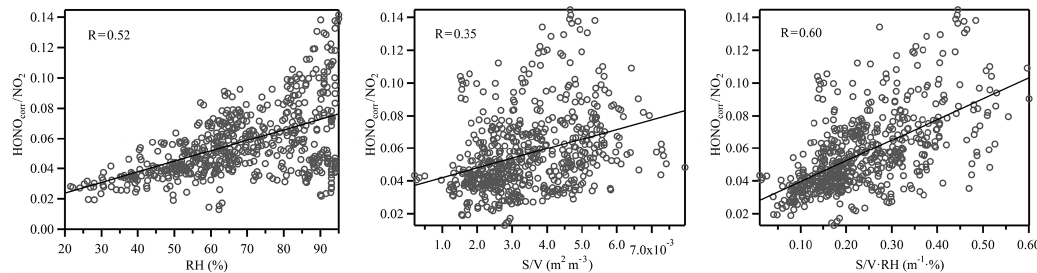
Figure 7. Nighttime correlations between HONO / NO 2 and RH, S/V and the product of S/V · RH.